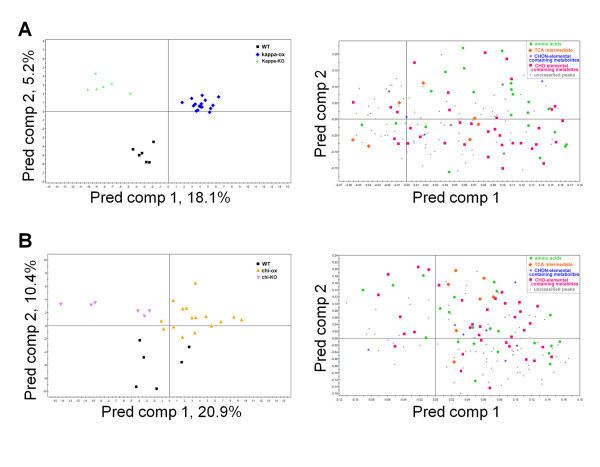
The OPLS-DA score scatter plots (left) and loading scatter plots (right) of shoot samples of (A) kappa-ox and kappa-KO (B) chi-ox and chi-KO. Wild type samples were used as controls. Each point represents an independent plant in the score scatter plots and an individual metabolite peak in the loading plots. (A) The OPLS-DA model of kappa samples shows two significant components, with R2X, R2Y and Q2Y values of 0.53, 0.95 and 0.65, respectively. (B) The OPLS-DA model of chi samples shows three significant components, with R2X, R2Y and Q2Y values of 0.31, 0.67 and 0.41, respectively. These models were validated using analysis of variance of cross-validated predictive residuals (CV-ANOVA) (pCV < 0.01). (Left) Black square, wild type; blue diamond, kappa-ox; pale-green star, kappa-KO; yellow triangle, chi-ox; green circle, psi-ox; pink-inverted triangle, chi-ox. (Right) Pale-green circle, amino acids; orange diamond, TCA intermediates; blue star, metabolites that consists of CHON-elemental composition; pink square, metabolites that consists of CHO-elemental composition; gray triangle, unclassified peaks. Number of biological replicates: wild type, n = 6; kappa-ox, n = 16; kappa-KO, n = 6; chi-ox, n = 16; chi-KO, n = 6; psi-ox, n = 17; psi-RNAi, n = 6. pCV, p-value of the probability level of the F-test in each model.